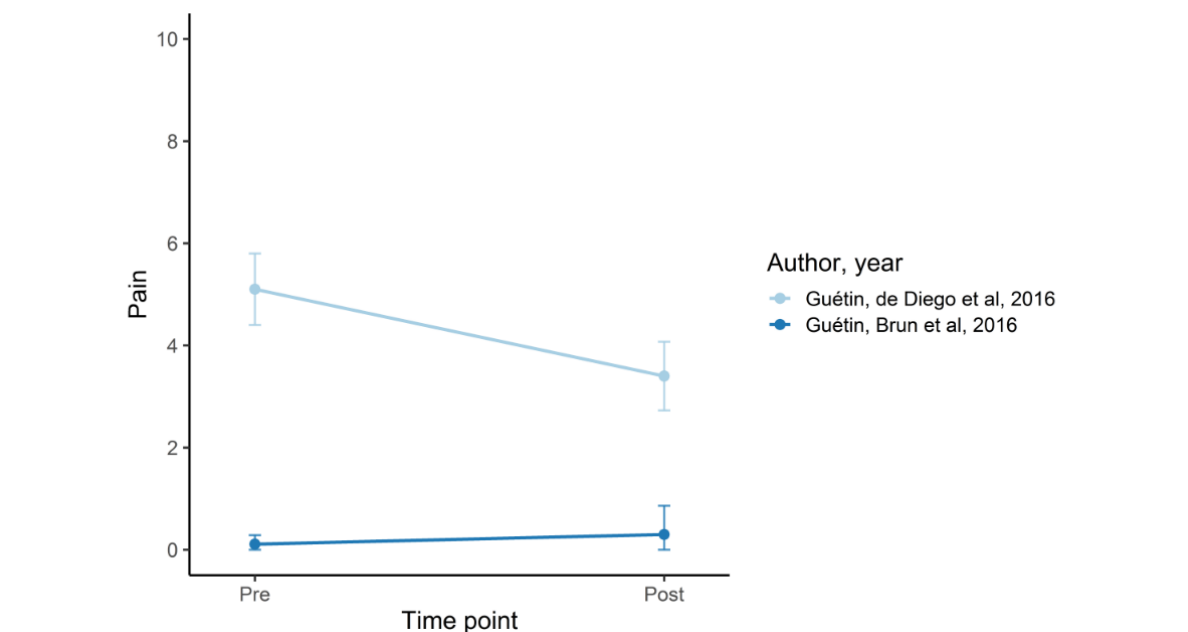
Figure 5. Decrease in pain in in-clinic before-after studies. Pain scale (Numeric Rating Scale):